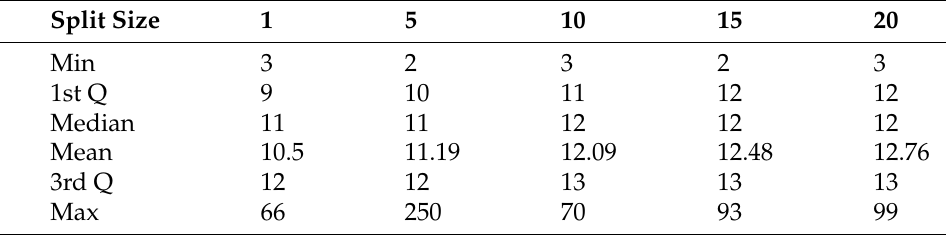
Table 5. Statistics of JSON RPC delay in Figure 9d.